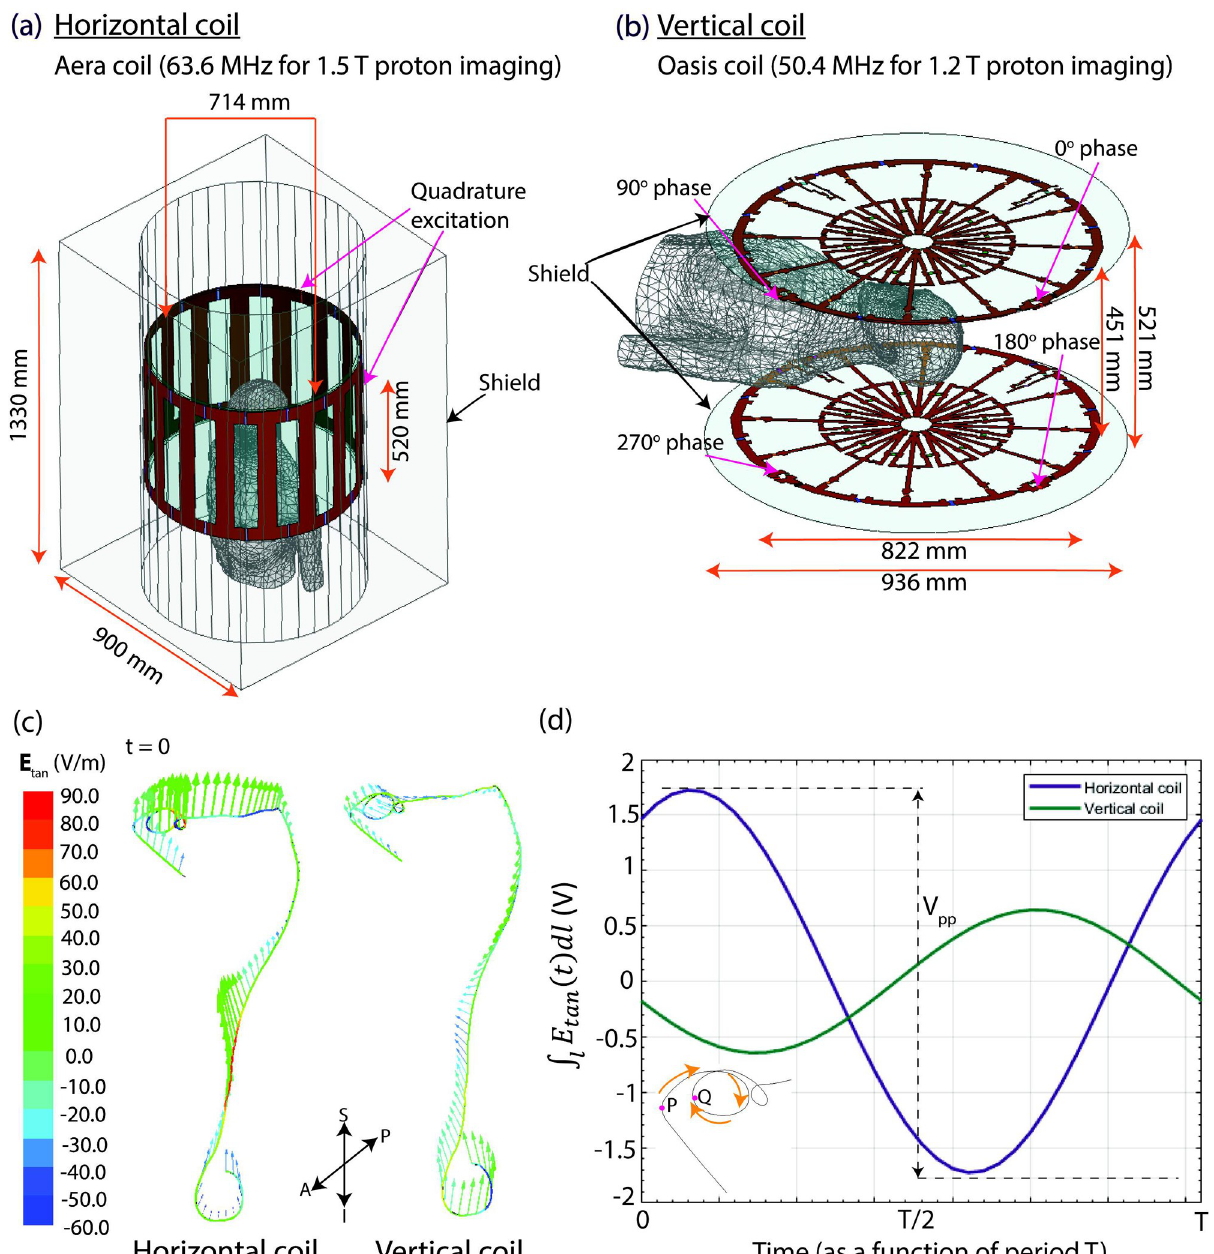
Fig 4. RF coil models and E tan distribution. (a) Numerical models of the 1.5 T Aera horizontal birdcage coil and (b) the 1.2 T Oasis radial planar birdcage coil. (c) The colormaps show the distribution of E tan and the green arrows indicate the incident electric field along the entire lead trajectory in the horizontal and vertical coils at time t = 0. (d) Time evolution of the induced voltage in the horizontal and vertical coils for the lead trajectory between points P and Q. Point P is at the location where the DBS lead exits the skull, and Point Q is 10 cm further along the extracranial portion of the